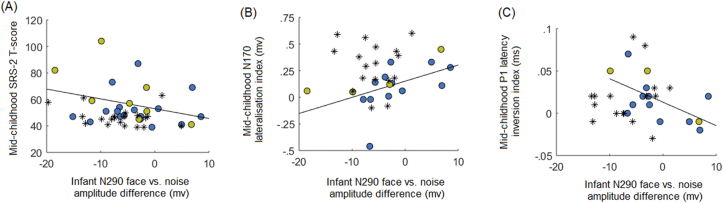
Longitudinal associations between face processing ERP indices in infancy and mid-childhood and mid-childhood ASD symptoms. Scatterplots show the associations between ERP indices of face processing at age 7-months and in mid-childhood and ASD symptoms in mid-childhood. The blue circles indicate data from the HR children without ASD and yellow circles indicate HR children with ASD; the regression lines represent the association between the variables in the HR group (HR-ASD and HR-non-ASD children combined). Black asterisks represent data points from the LR group and are shown only for visual comparison with the HR group associations. Panel (A) shows the negative association between the N290 amplitude difference score for face versus noise stimuli in infancy and SRS-2 scores in mid-childhood; larger (more negative) N290 difference scores (indicating larger N290 amplitude for face vs noise stimuli) were associated with more severe social-communication problems in mid-childhood. Panel (B) shows the positive association between the N290 amplitude difference score in infancy and the extent to which the N170 was right-lateralised in mid-childhood; larger (more negative) N290 difference scores (larger amplitudes for faces vs noise) were associated with less right-lateralisation of the N170 in mid-childhood. Panel (C) shows the negative association between the N290 difference score in infancy and the extent to which latency of the P1 was slower for inverted than upright faces in mid-childhood; larger (more negative) N290 difference scores (larger amplitudes for faces vs noise) were associated with larger latency increases for inverted versus upright faces in mid-childhood.